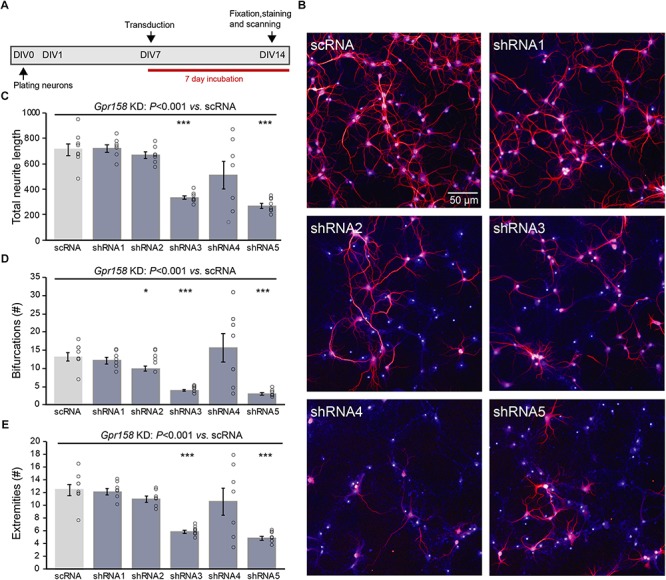
Gpr158 knock down leads to reduced neuronal outgrowth of hippocampal primary neurons. (A) Experimental set-up of in vitro Gpr158 knockdown (KD). Viral transduction with independent shRNAs occurred from DIV7 to DIV14, and morphological analysis occurred at DIV14. (B) Representative images for control (scRNA) and Gpr158 KD (shRNA1–5) neurons (red: MAP2, blue: nuclei). (C–E) Morphological analysis after Gpr158 KD at DIV14 (n = 7–8 wells; see Online Resource 6) shows an overall effect of the shRNA treatment for all parameters [neurite length (C), number of bifurcations (D) and number of extremities (E)], as tested by Kruskal–Wallis (P < 0.001). Whereas shRNA3 affected all 4 parameters, the other shRNAs had a more limited effect for 1–3 of these parameters. Apart from a significant downregulation in number of protrusions, shRNA5 gave a similar strong effect as shRNA3, indicative of a Gpr158-related effect. Data are presented as mean ± SEM with individual data points indicated. Asterisks indicate significant differences compared with control (scRNA) assessed by Student’s t-test (Supplementary Table 3), ∗P ≤ 0.050; ∗∗∗P ≤ 0.001.